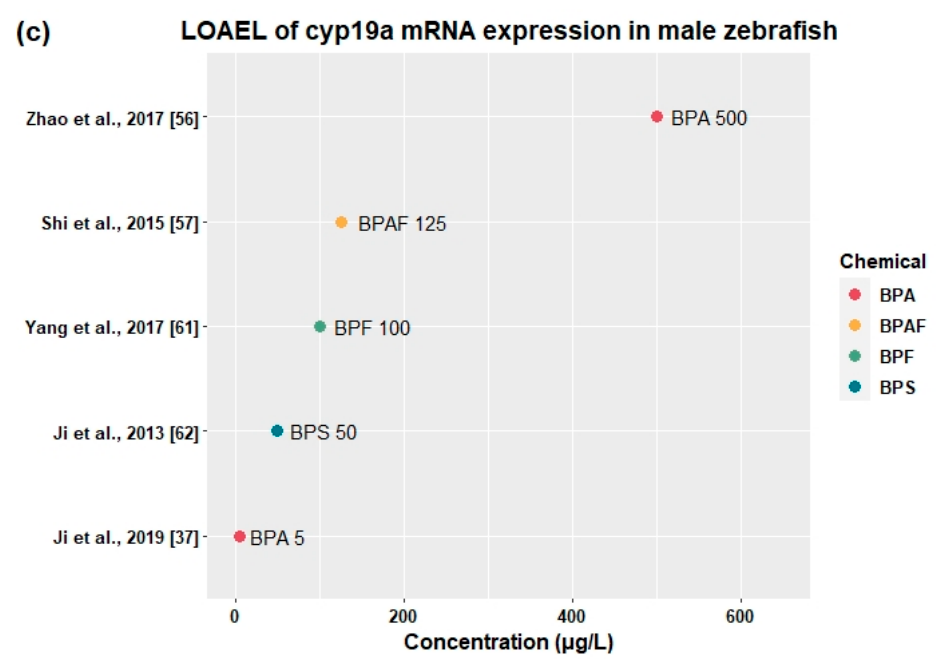
Figure 4. Lowest observed adverse effect level (LOAEL) of 17 β -estradiol (E2) hormone ( a ), testosterone (T) hormone ( b ), and cyp19a mRNA expression ( c ) in male zebrafish exposed to BPA, BPAF, BPF, BPS, and BPSIP.